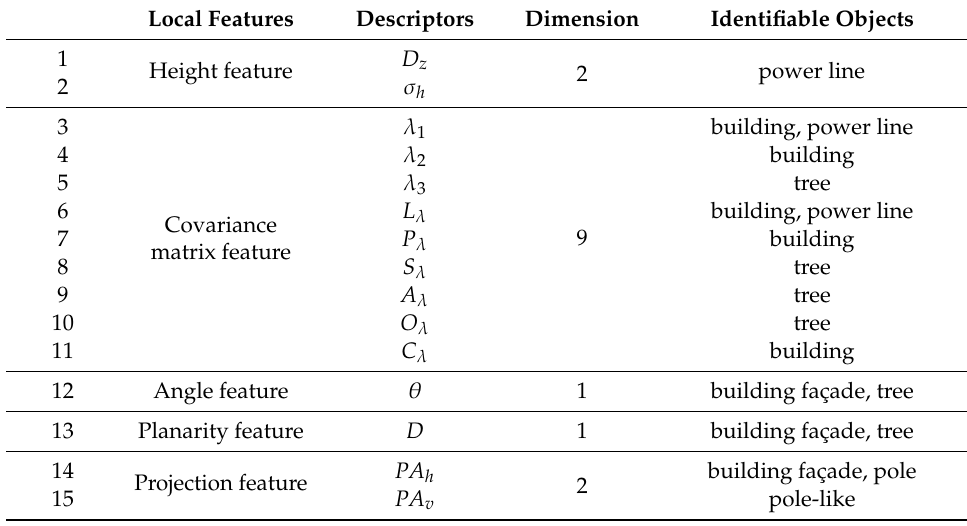
Table 1. Feature vectors set for